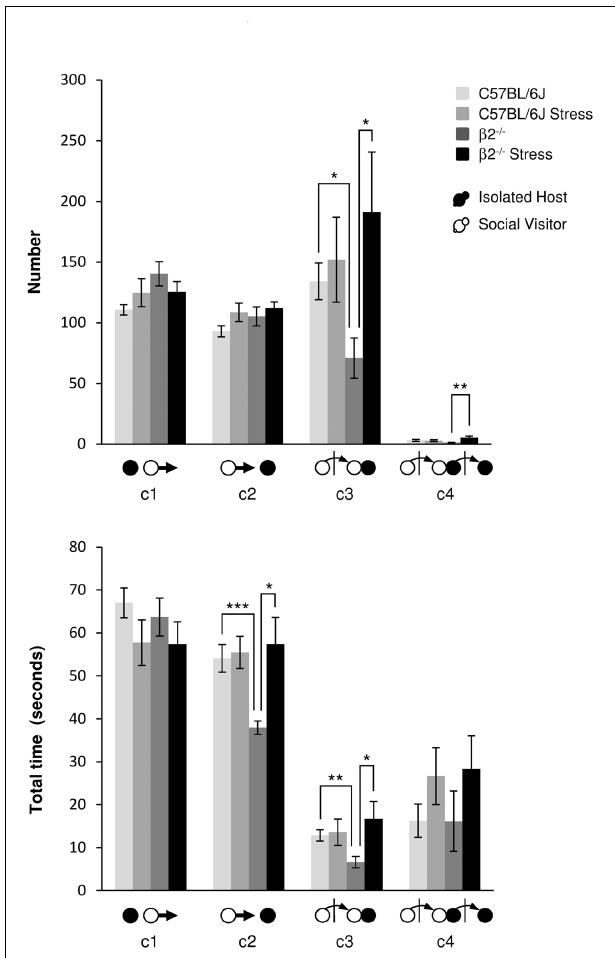
FIGURE 3 | Dynamic events during social interaction: events initiated by the Social Visitor mouse. The number ( Top ) and the total time ( Bottom ) of the dynamic events (c1 to c4 as referred in Table 1 and Supplementary Table 1) were quantified during the 4min of the social interaction task. IH mice were submitted or not to an acute stress (C57BL/6J: n = 11; β 2 − / − : n = 9; C57BL/6J Stress: n = 8; β 2 − / − Stress: n = 7). Data are expressed as means ± SEM. ∗ p ≤ 0 . 05, ∗∗ p ≤ 0 . 01, ∗∗∗ p ≤ 0 .